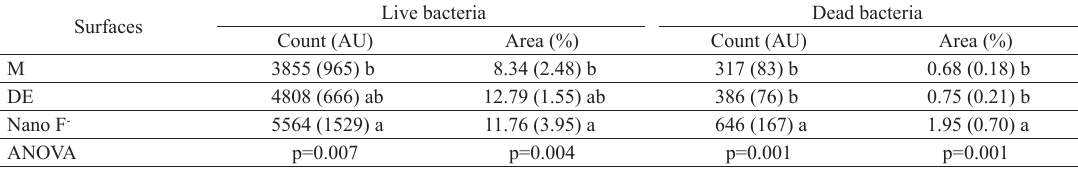
Table 1. Average (SD) values of the bacterial count (AU) and of the percentage of area (%) including live and dead bacteria, according to surface treatment. M=machined, DE=double acid-etched, Nano F - = DE with deposition of fluoride ions. Means followed by different letters within the same column denote a significant